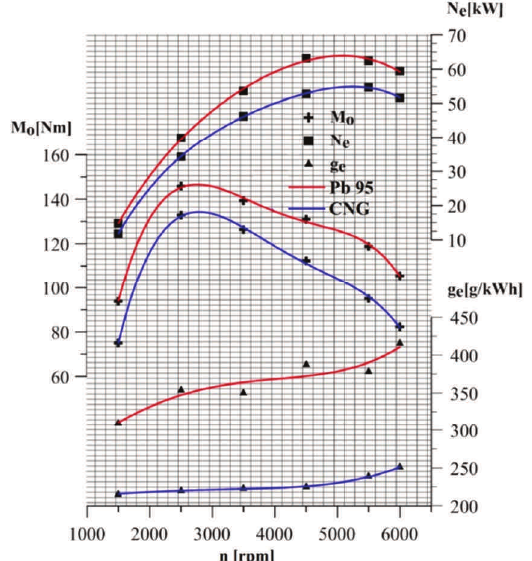
Fig. 4. External torque-speed characteristics of the Fiat 0.9 TwinAir en- gine, fuelled by Pb 95 petrol and CNG